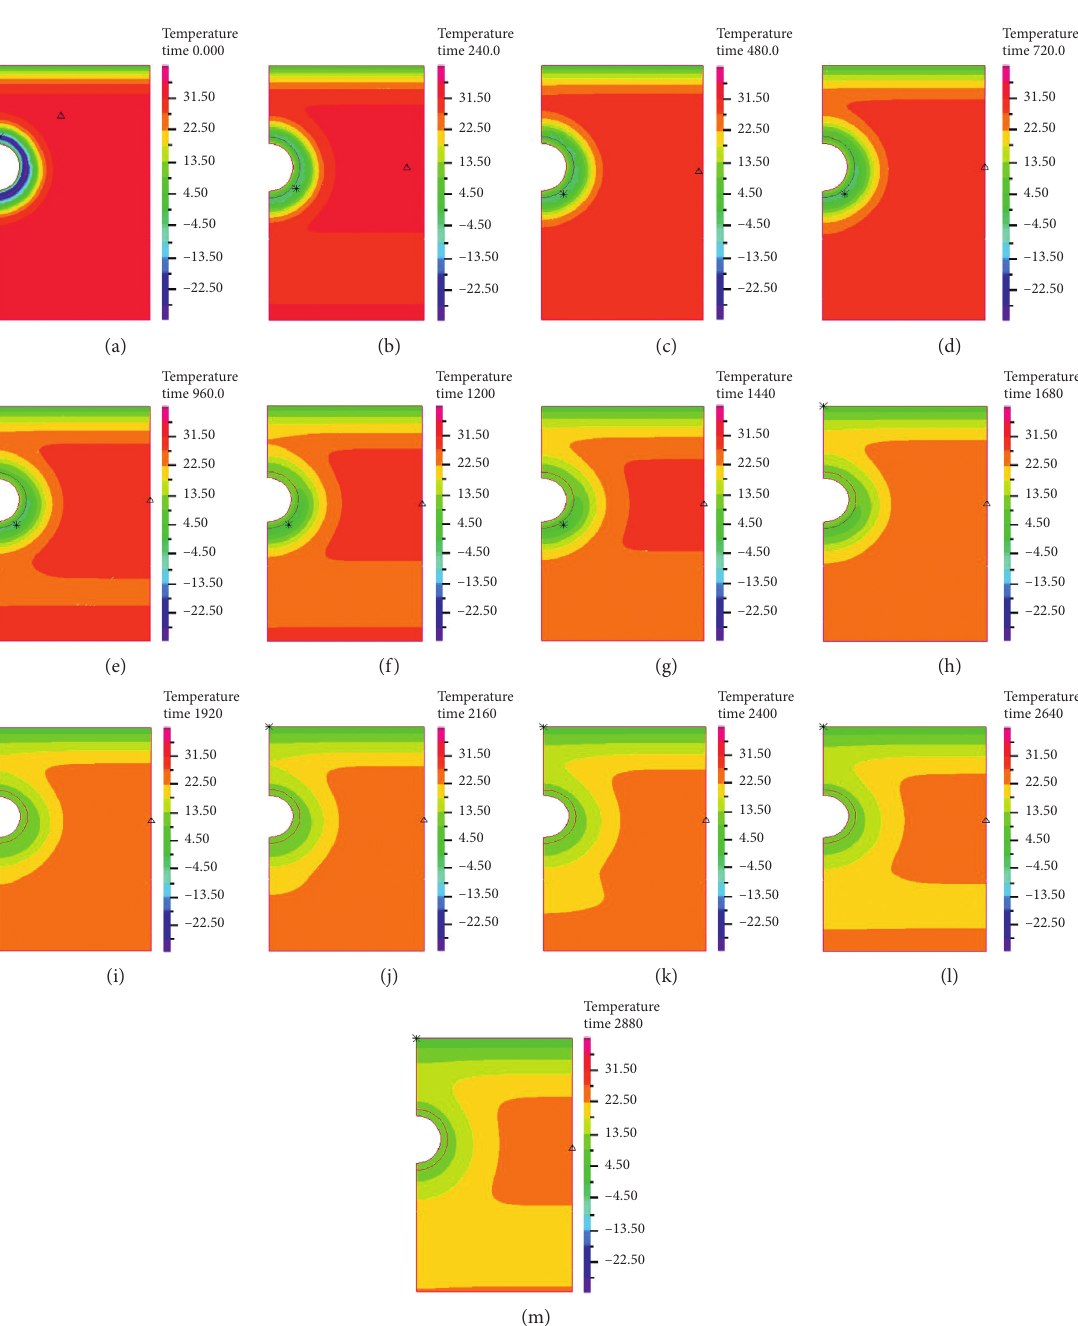
Figure 5: Temperature field contour plots at section of X � 3m with different natural thawing times: (a) 0 days; (b) 10 days; (c) 20 days; (d) 30 days; (e) 40 days; (f) 50 days; (g) 60 days; (h) 70 days; (i) 80 days; (j) 90 days; (k) 100 days; (l) 110 days; (m) 120